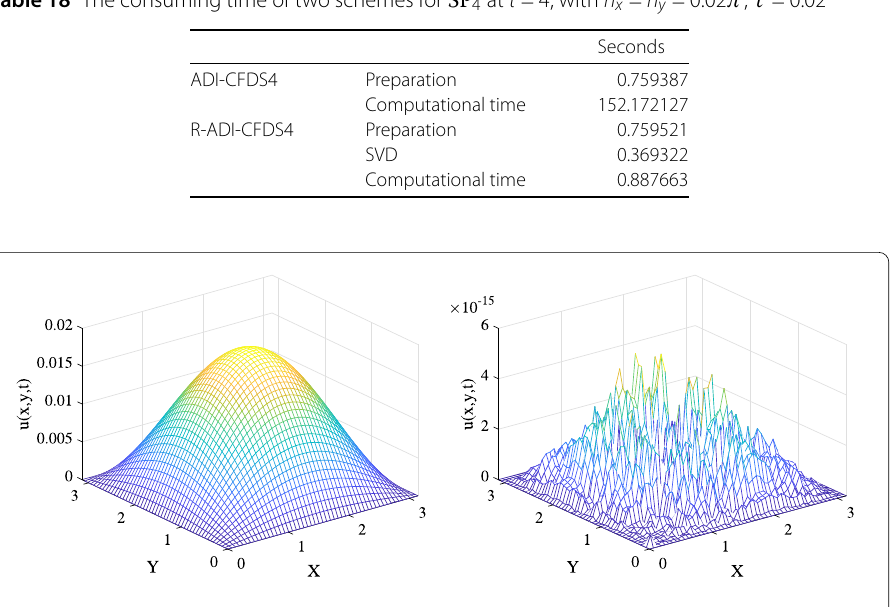
Figure 11 The figures of solutions of R-ADI-CFDS4(left) and difference(right) between R-ADI-CFDS4 and ADI-CFDS4 at t = 4, with h x = h y = 0.02 π and τ = 0.02 for SP 4